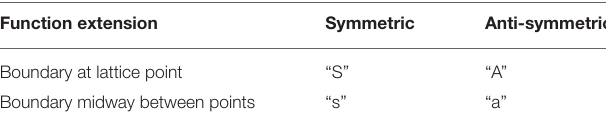
TABLE 1 | Individual boundary conditions covered by standard discrete trigonometric transforms ( DCT and DST ). Function